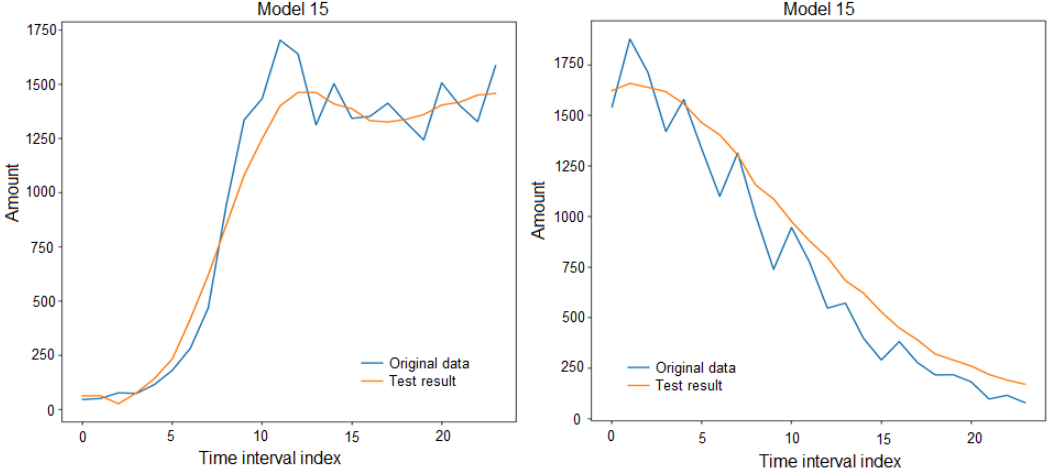
Figure 10. Number of vehicles measured over two time periods, and the number of vehicles forecasted by the neural network over the same periods.